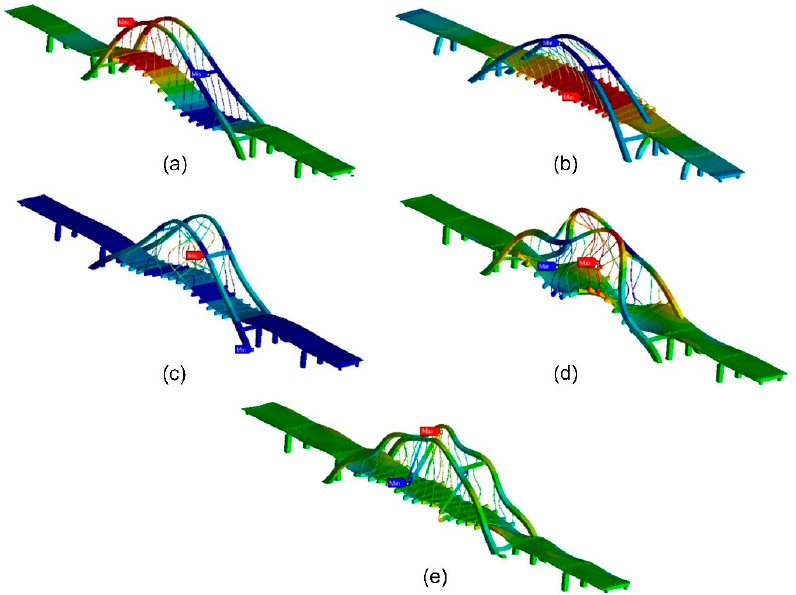
Figure 11. The calculated modes of vibration: ( a ) first; ( b ) second; ( c ) third; ( d ) fourth; ( e ) fifth.